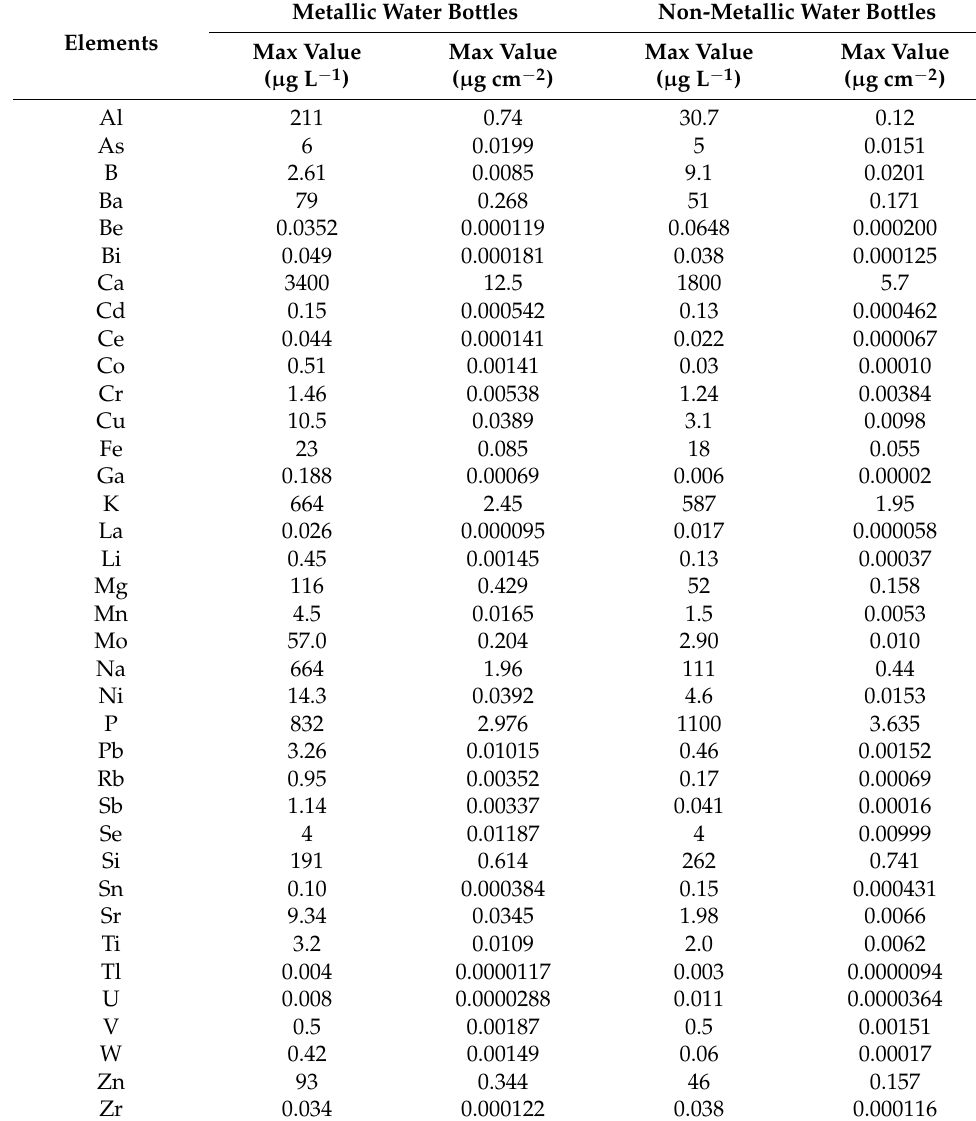
Table 4. Maximum levels found for each studied element in water samples stored in metallic (stainless steel and aluminum) and non-metallic bottles, expressed both as µ g L − 1 and µ g cm − 2